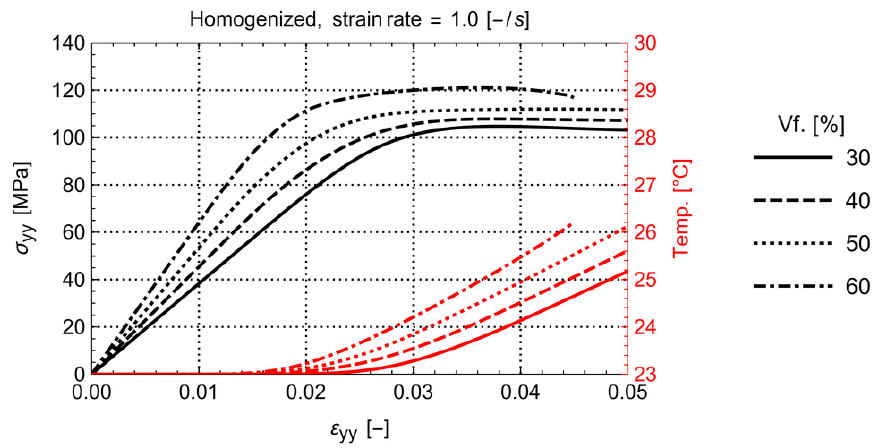
Figure 5. Homogenized stress-strain and temperature-strain with volume fraction.